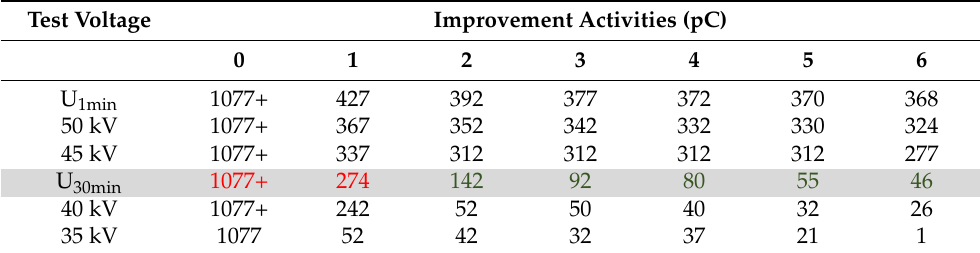
Table 1. AC voltage test results for phase-C to ground.